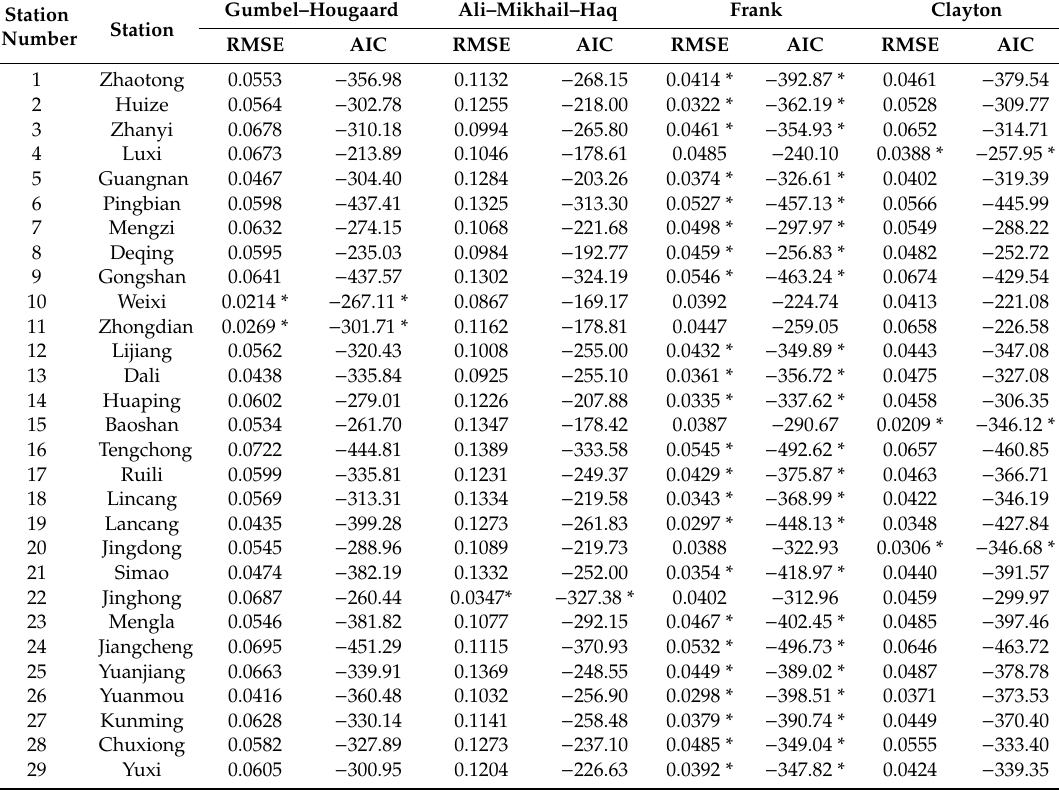
Table 5. Goodness-of-fit tests for